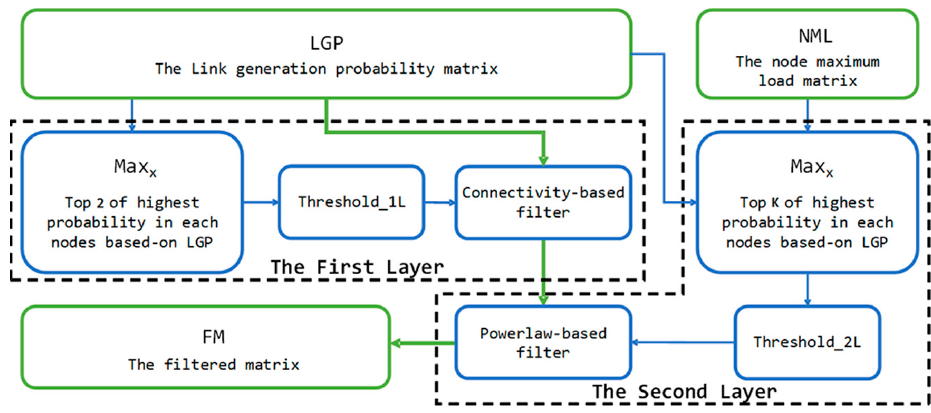
Figure 4. Structure of the adaptive multilayer filter algorithm. The pseudo code for the adaptive multilayer filtering algorithm is shown as Algorithm 2: Algorithm 2 Adaptive Multilayer Filter